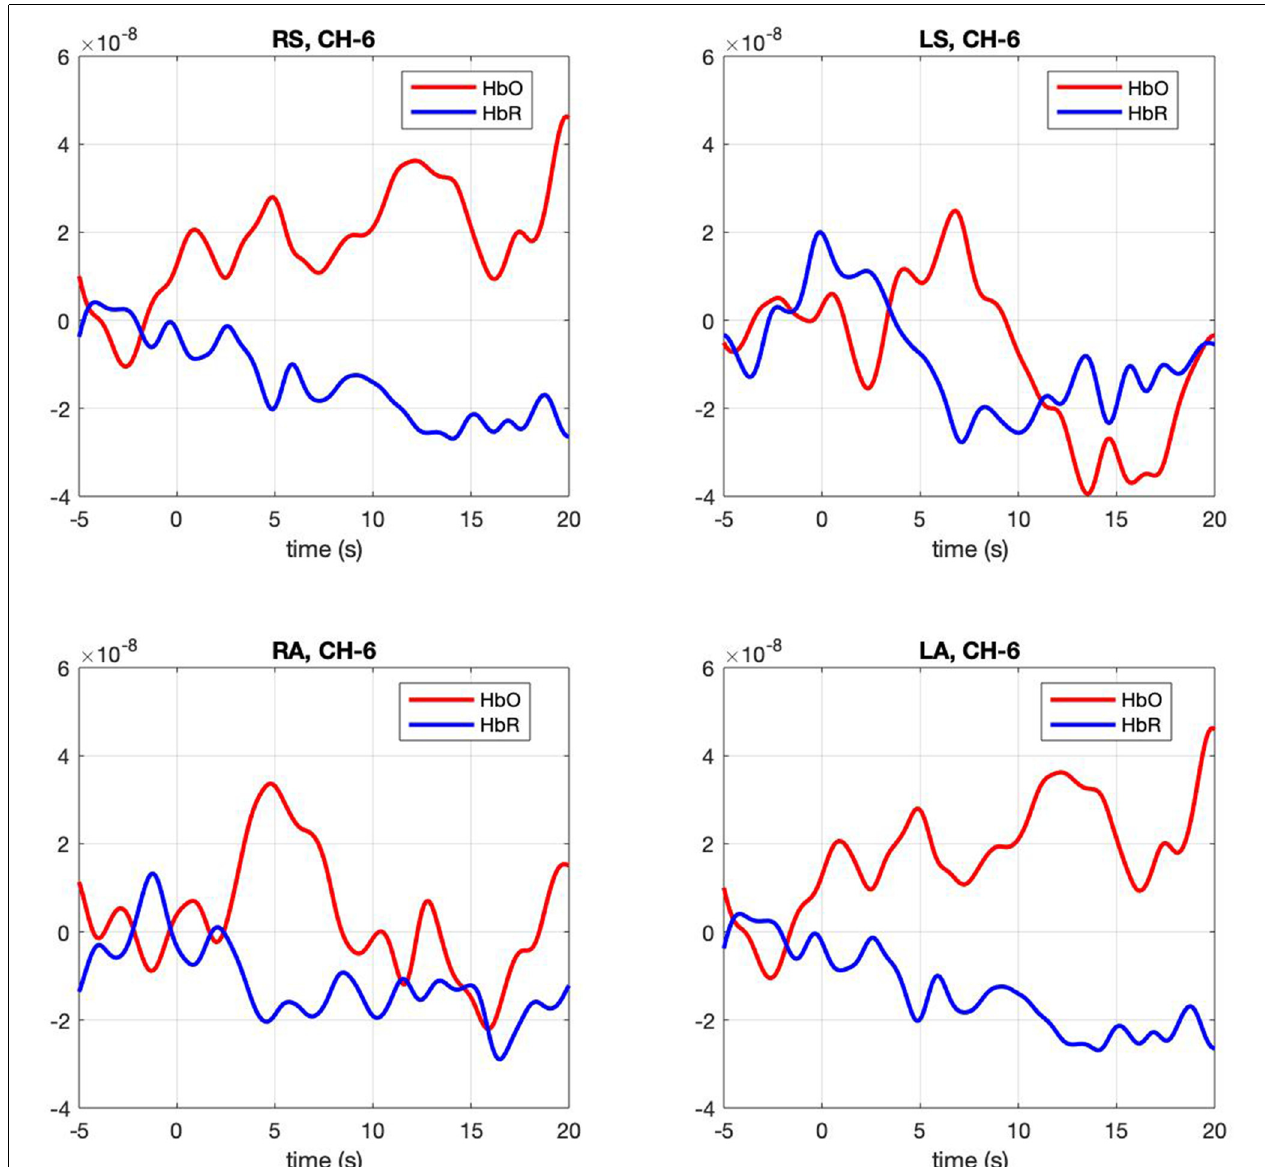
FIGURE 3 | Hemodynamic response, HbO (Red) and HbR (Blue), across four conditions (RS, right self; LS, left self; RA, right across; LA, left across) across the significant channel 6.